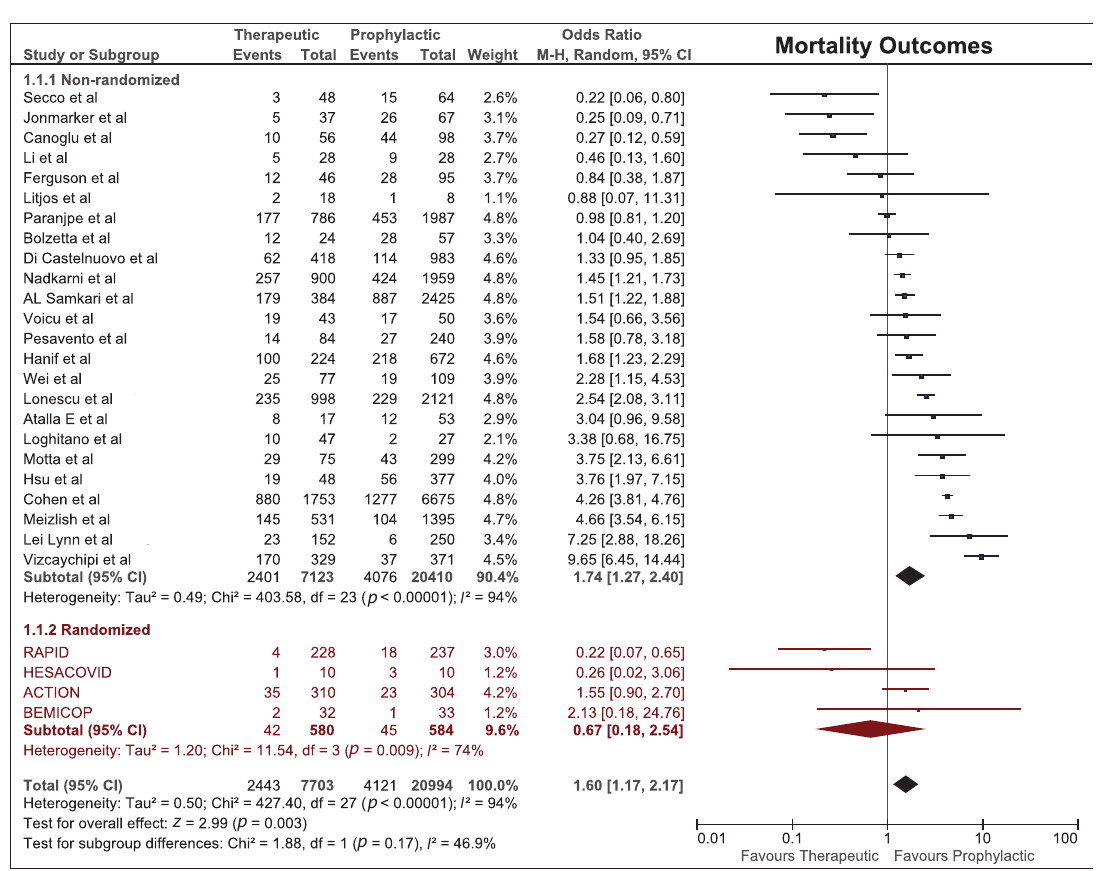
Fig. 2 Forest plot for mortality outcomes with therapeutic versus prophylactic doses of anticoagulation. CI, con fi dence interval.